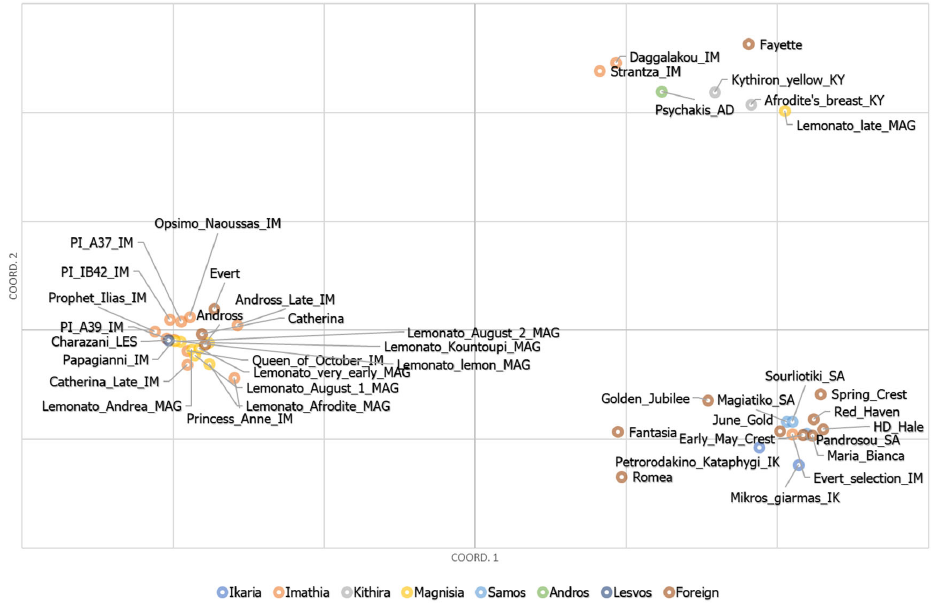
Figure 6. Principal Coordinates Analysis (PCoA) for ISSR molecular markers for 43 local and old foreign peach and nectarine cultivars/accessions.